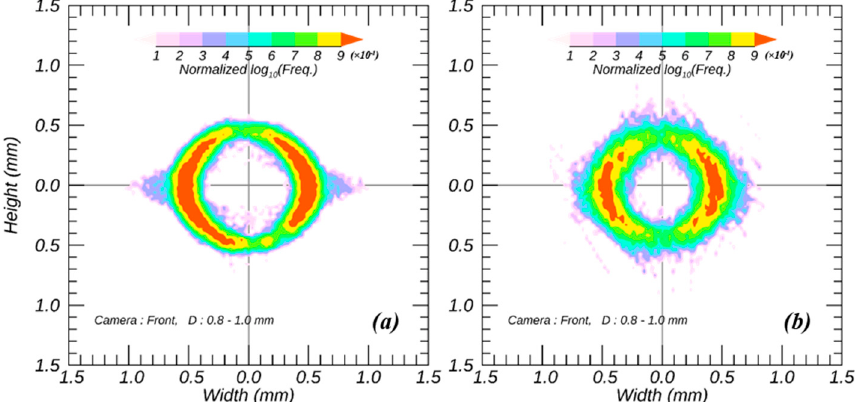
Figure 3. Frequency contours in the normalized logarithmic scale (0–1) indicated in color for D = 0.8–1.0 mm of ( a ) rainfall and ( b ) snowfall detected by the front-view camera of the 2DVD. The frequencies were obtained through a grid with a resolution of 0.03 mm × 0.03 mm and normalized with respect to the maximum value of log frequency in the whole grid.